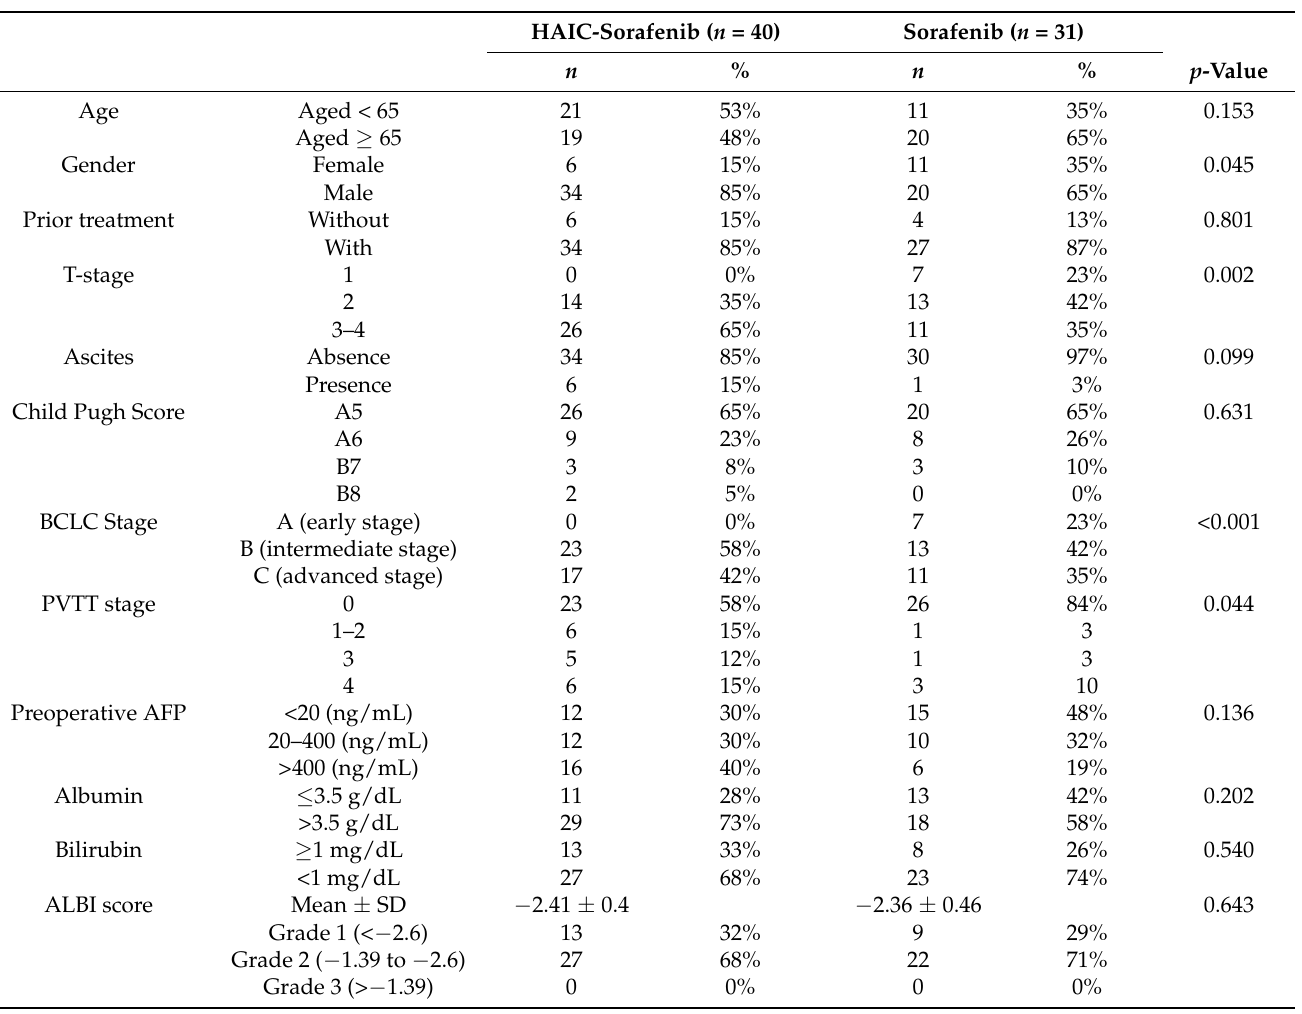
Table 1. Patient